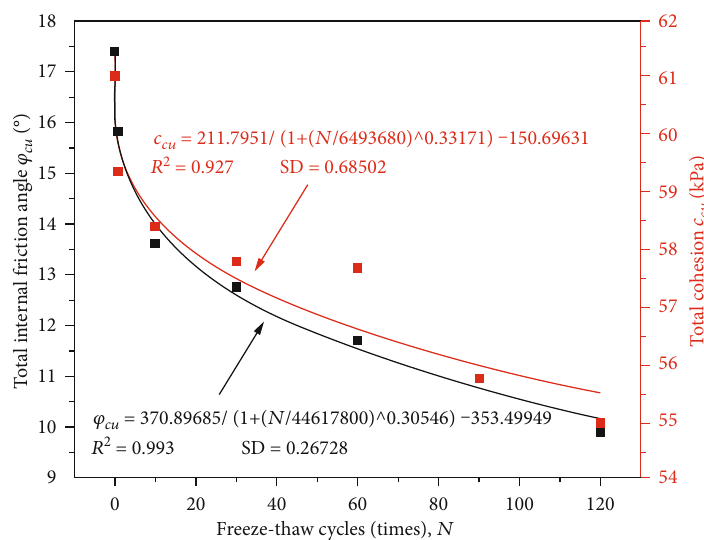
ϕ cu and cu under freeze-thaw cycles.